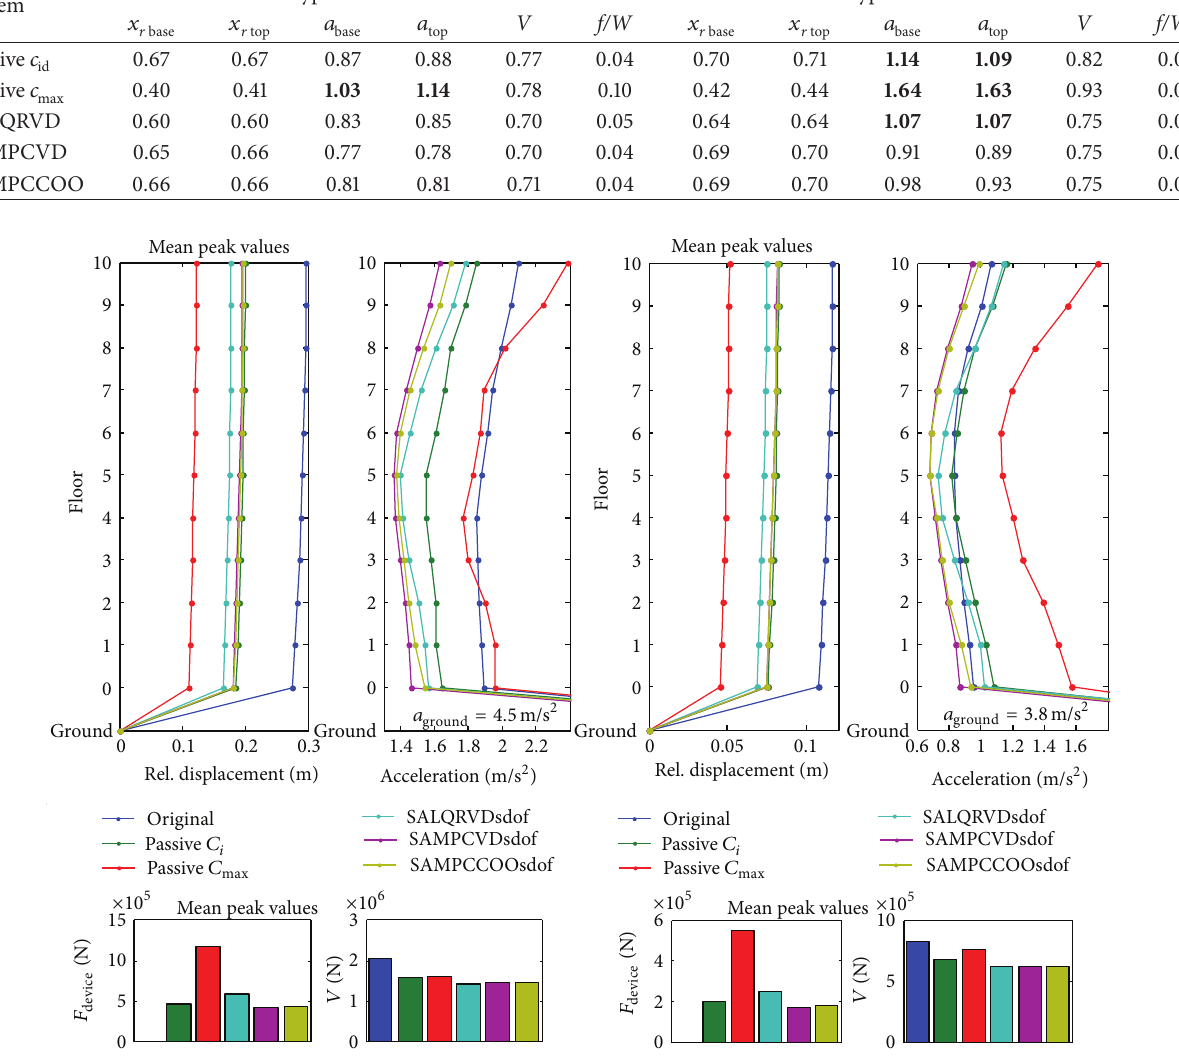
with weighting values determined as for de SDOF case; see Section